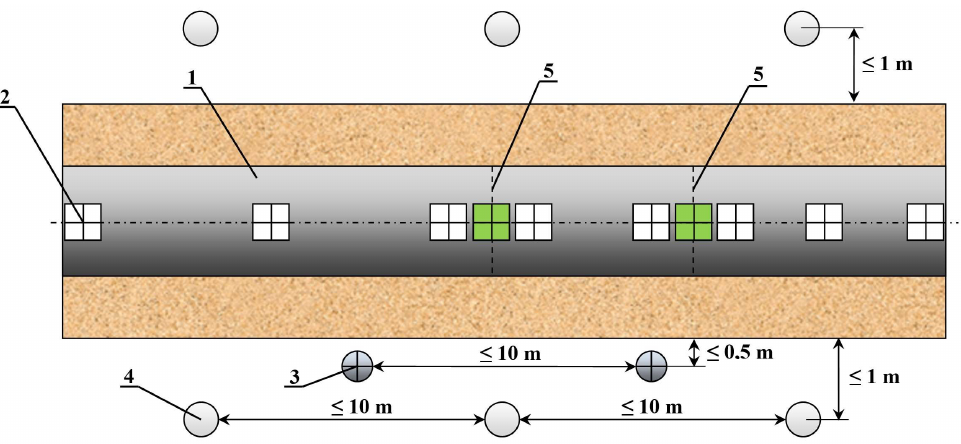
Figure 2. Scheme of laser scanning of a pipeline section: 1—repaired section of the main pipeline; 2—cross marker; 3—spherical marker; 4—laser scanner; 5—cutting place.